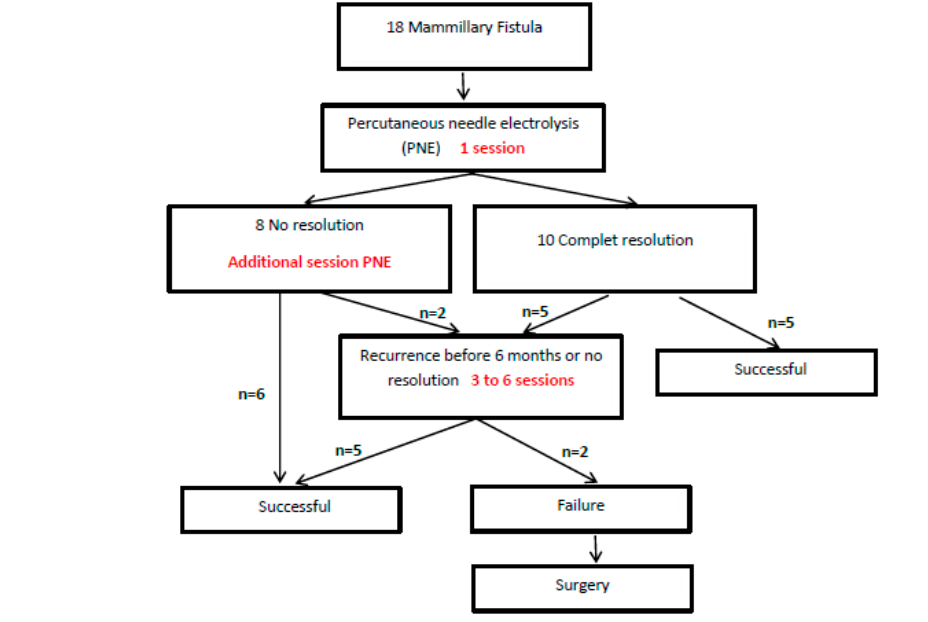
Figure 3. Flow diagram of the patients in this study .